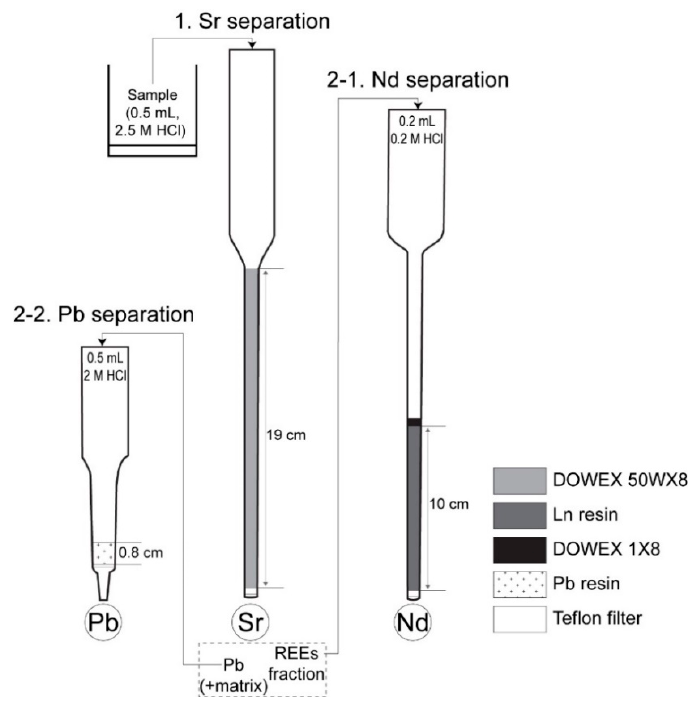
Figure 1. Sequential Sr–Nd–Pb separation